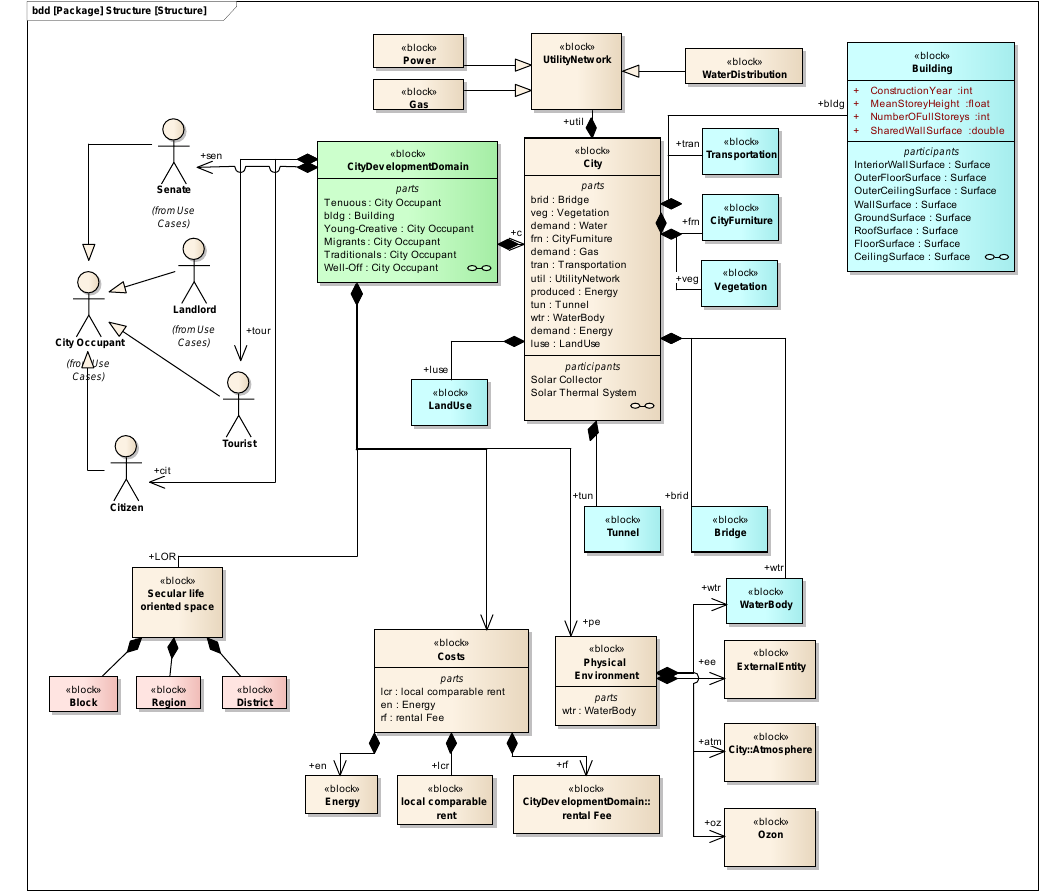
Figure 6. CityDevelopmentDomain block definition diagram - overall structure including the city and the external environment as